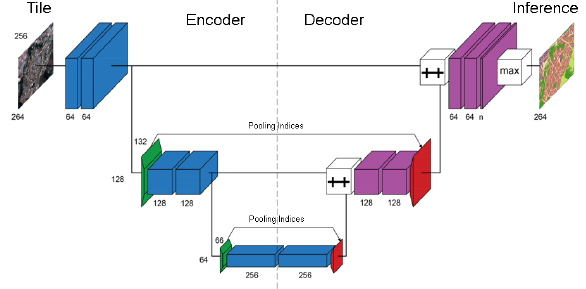
Figure 1. Proposed architecture based on Deconv-Net and U-Net. Blue : 3 × 3 convolution, green : 2 × 2 max pooling, red : 2 × 2 unpooling, Violet : 3 × 3 deconvolution, ++ : concatenation, max : softmax.